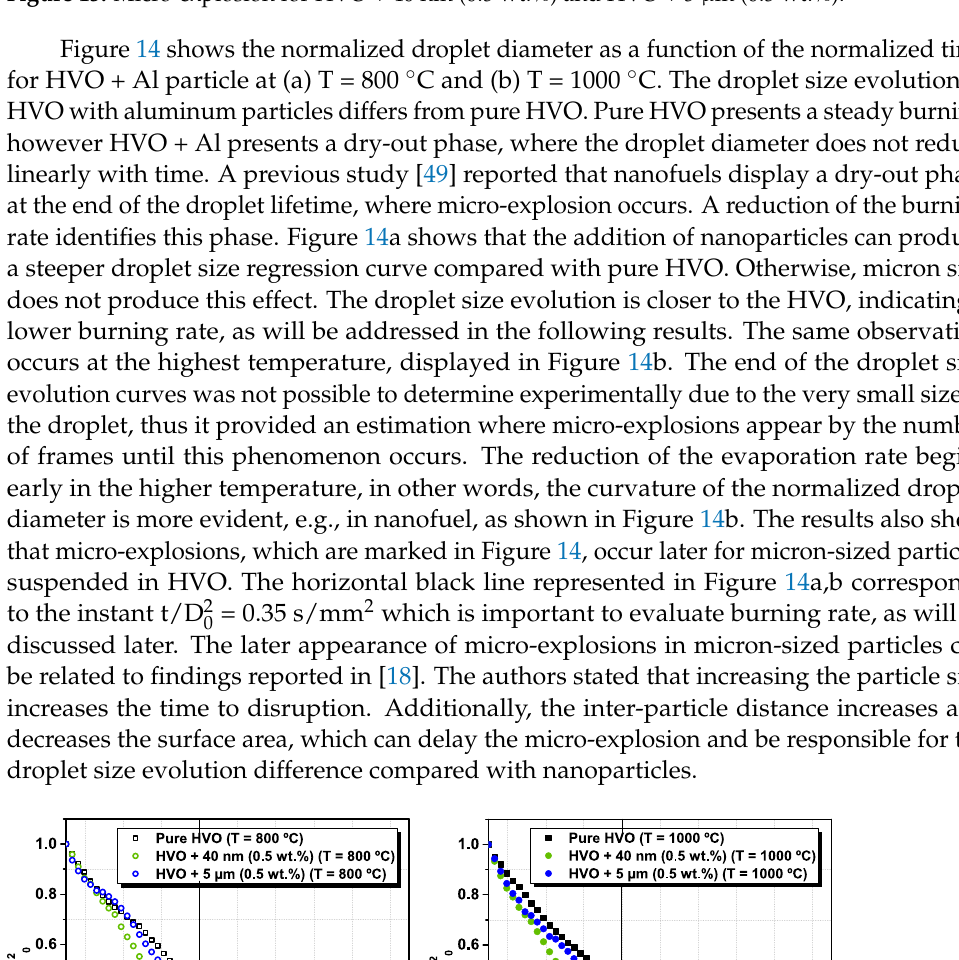
Figure 13. Micro-explosion for HVO + 40 nm (0.5 wt.%) and HVO + 5 µ m (0.5 wt.%).